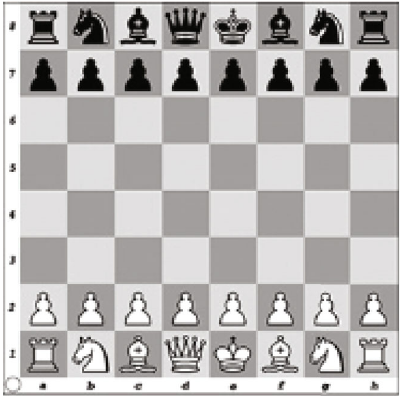
Figure 1: The chessboard setup